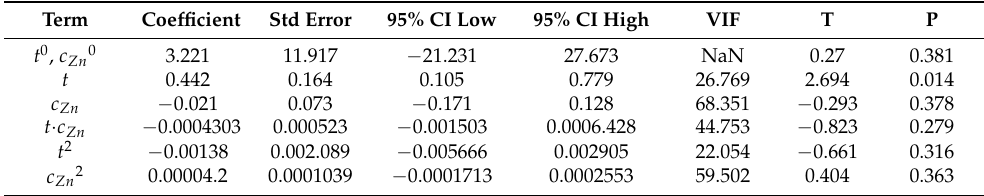
Table 7. Statistical characteristics of the cubic regression by two variables for the mass of the lettuces.